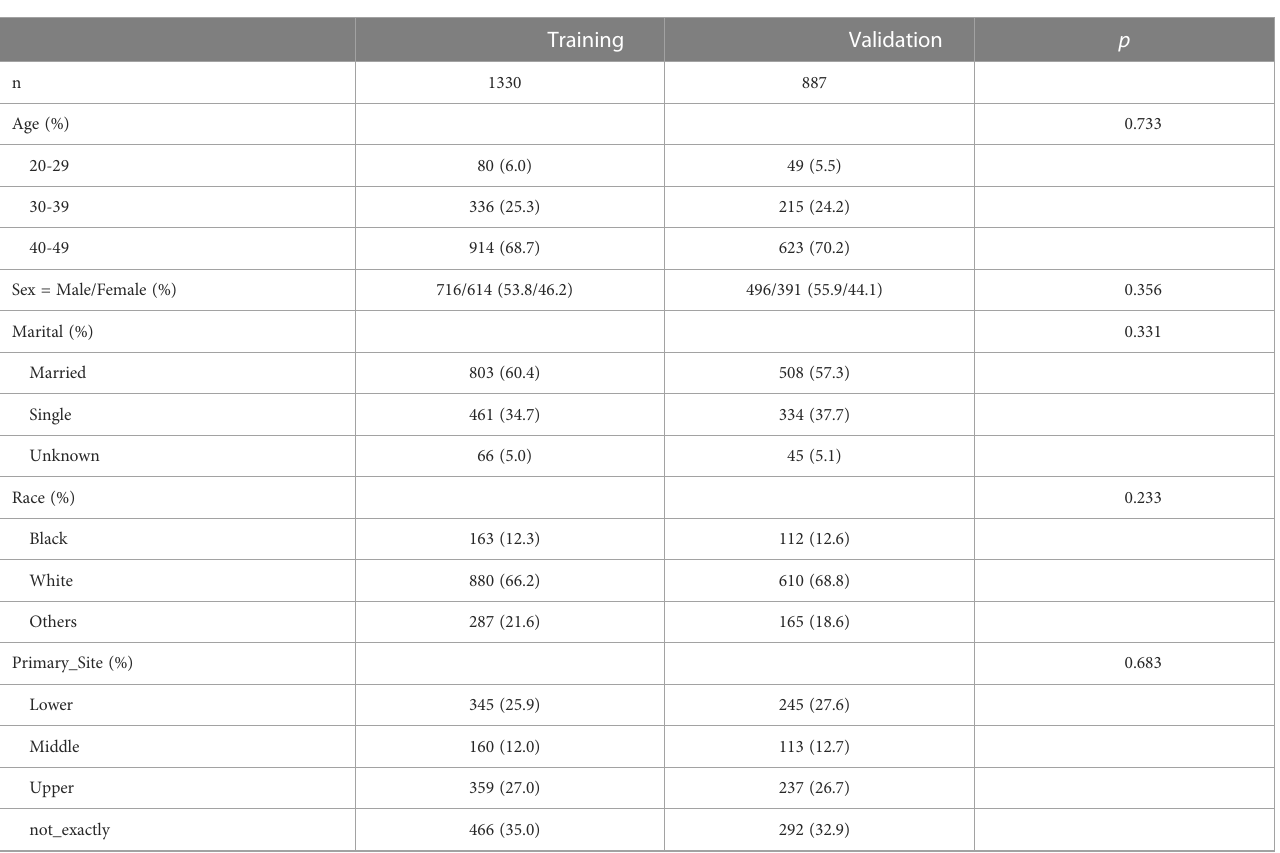
TABLE 2 Baseline clinical characteristics of patients in training set and validation